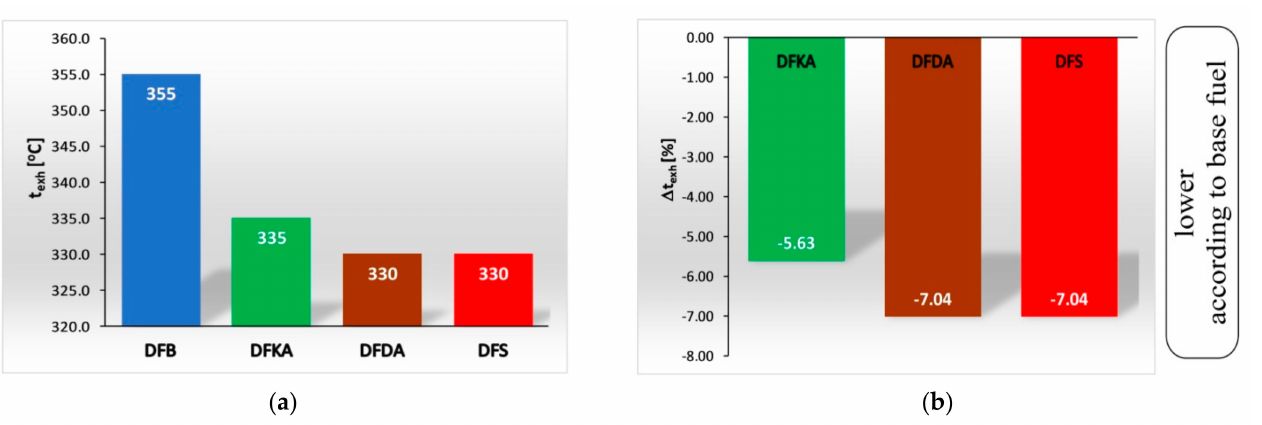
Figure 9. ( a ) Exhaust gas temperature (texh) for tested fuels. ( b ) Percent change in exhaust gas temperature ( ∆ t exh ) for tested fuels relative to t exh for DFB (base